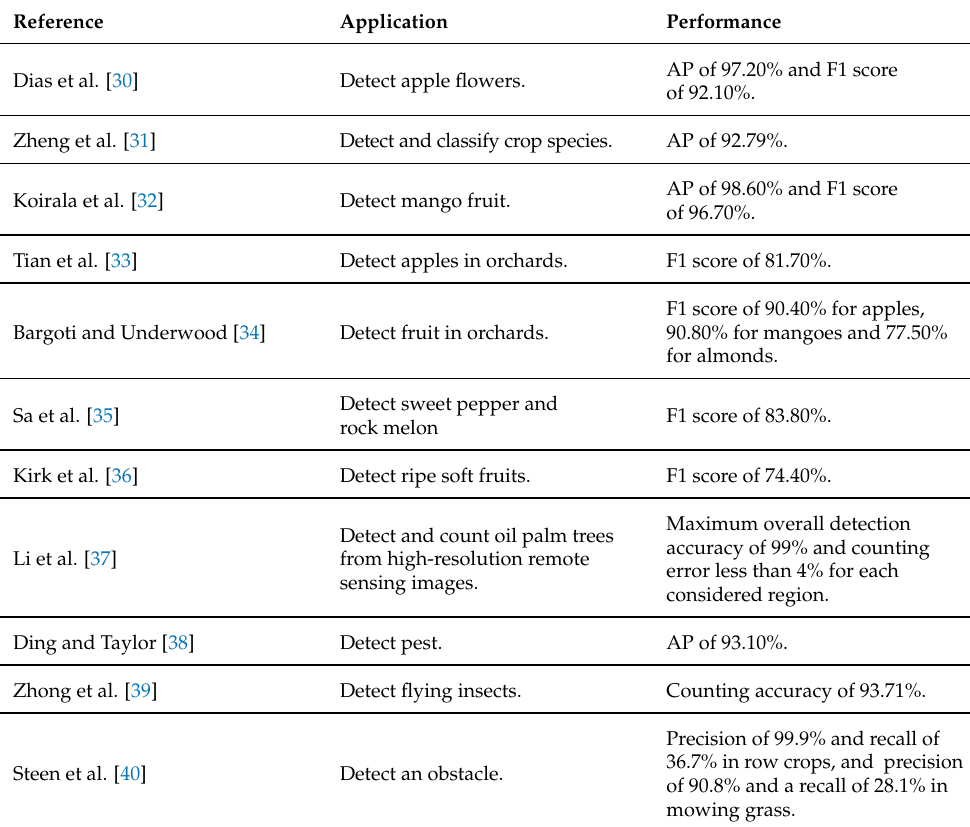
Table 2. Summary of the current state-of-the-art on Deep Learning (DL)-based object detection in